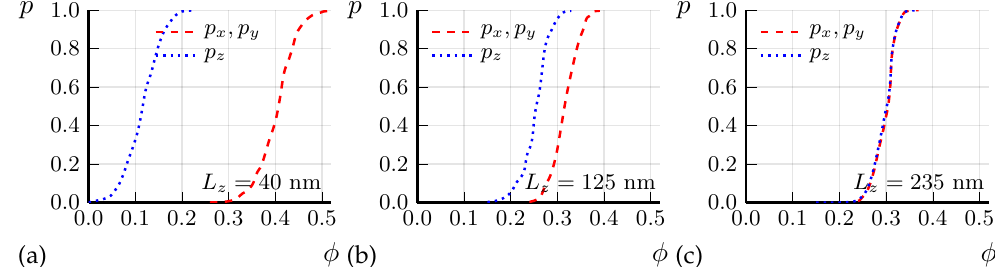
Figure 5. Calculated probability p of current percolation along the in-plane x (red dashed curves) and out-of-plane z (dotted blue curves) axes via the SC domains of spheroid shape with aspect ratio a z / a x = 0.12 as a function of SC volume fraction φ in a sample of thickness L z = 40 nm ( a ), L z = 125 nm ( b ), and L z = 235 nm ( c ). The sample area in the conducting x - y plane is taken 2 × 2 µm 2 , as in our experiment. The domain height in our calculations is d z = 20 nm. The percolation probability is almost isotropic for the sample thickness L z = 235 nm at a z / a x = 0.12.